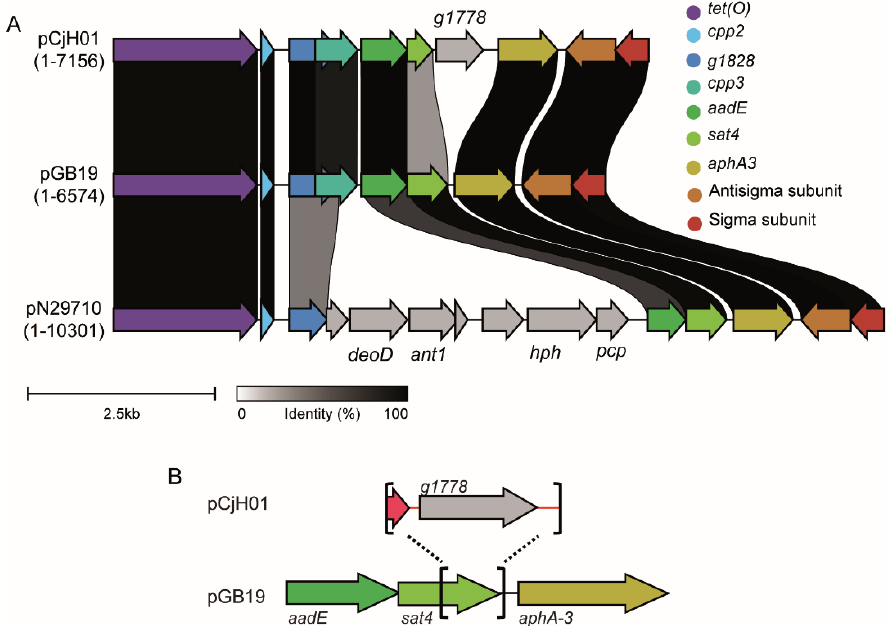
Figure 4. The new variant of the aadE-sat4-aphA-3 gene cluster of pCjH01. ( A ). Comparison between aadE-sat4-aphA-3 gene clusters among the pCjH01, pGB19 (CP071593.1), and pN29710 (CP004067) plasmids. Homology at the protein level is indicated both with a color code according to the legend and ribbons indicate the pairwise percent identity with respect to pGB19. ( B ) Brackets and dotted lines demarcate the substitution of the 3 ′ sat4 sequence and insertion of a new gene, g1778, in pCjH01 with respect to pGB19.